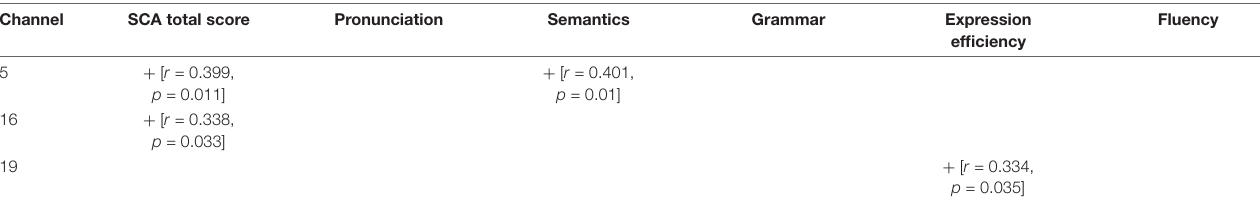
TABLE 5 | Correlation between neural activation to weak-prosodic (WP) and evaluation scores of speech communication ability (SCA) test. Channel SCA total score